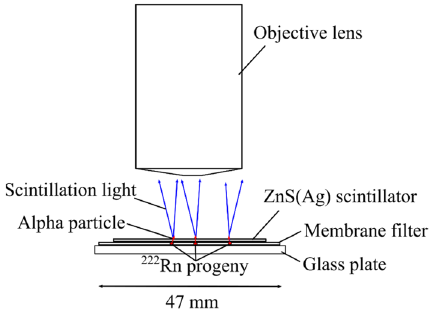
Figure 13. Schematic drawing of the 222 Rn progeny imaging.